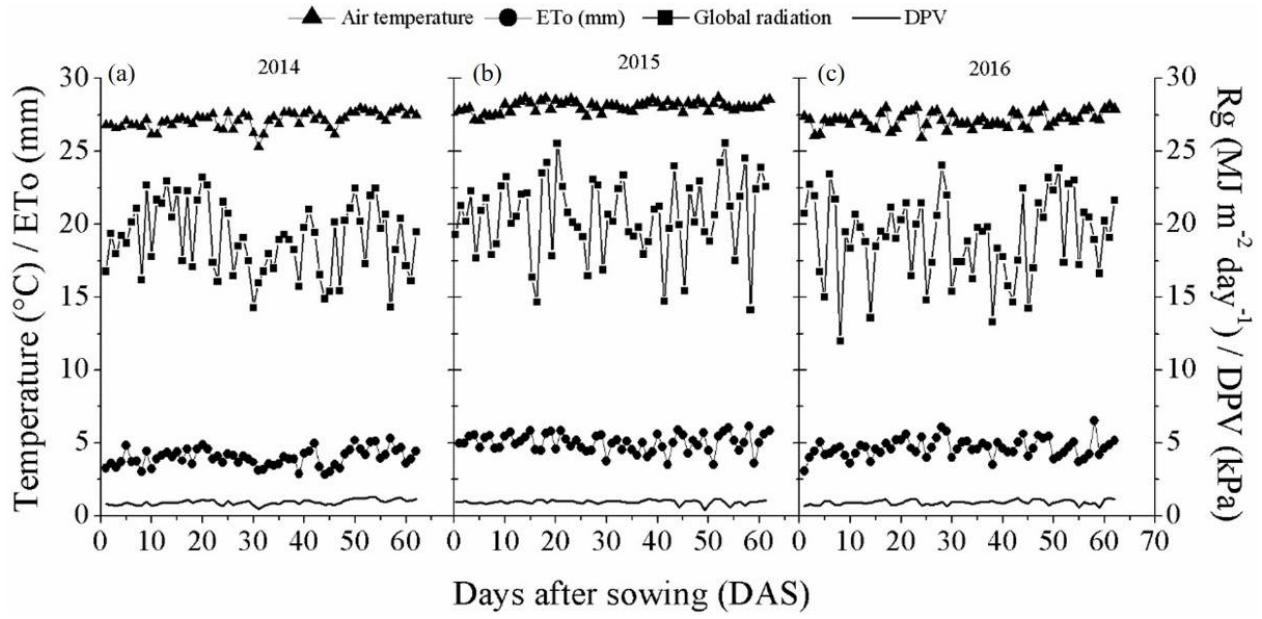
Figure 1. Daily mean values of air temperature, reference evapotranspiration, vapor pressure deficit, and global solar radiation during in 2014 ( a ), 2015 ( b ), and 2016 ( c ) with cowpea in Castanhal-PA. The ET 0 presented mean values of 4.01, 5.03, and 4.67 mm · dia − 1 in 2014, 2015, and 2016, respectively. The Rg during the 2014, 2015, and 2016 experiments were 19.22,